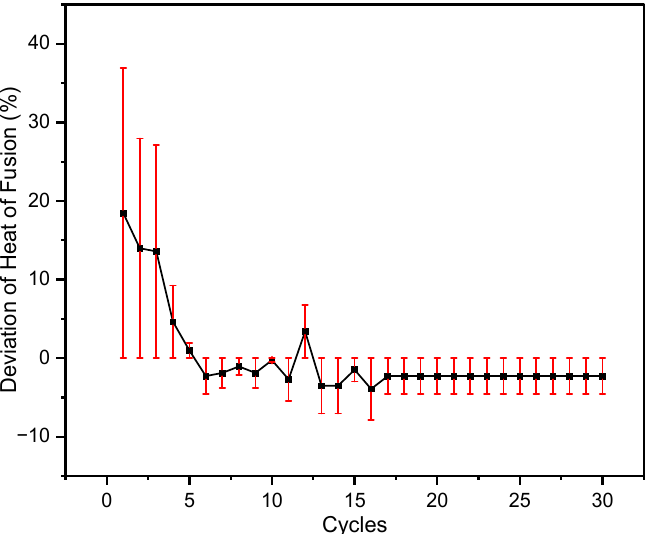
Figure 4. Deviation of heat of fusion with error bars illustrated for each cycle from the average calculated value for the best-chosen sample, i.e., 32 mol% LiCl-68 mol%